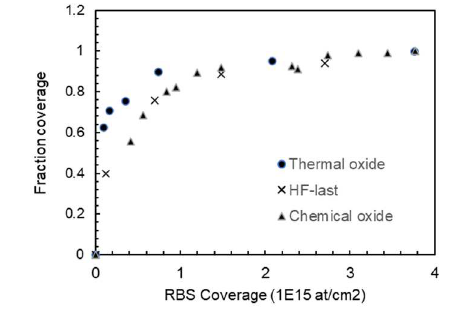
Figure 1 : Evolution of the fractional coverage of Al 2 O 3 layer grown on various Si surfaces as a function of deposited material as measured by RBS.